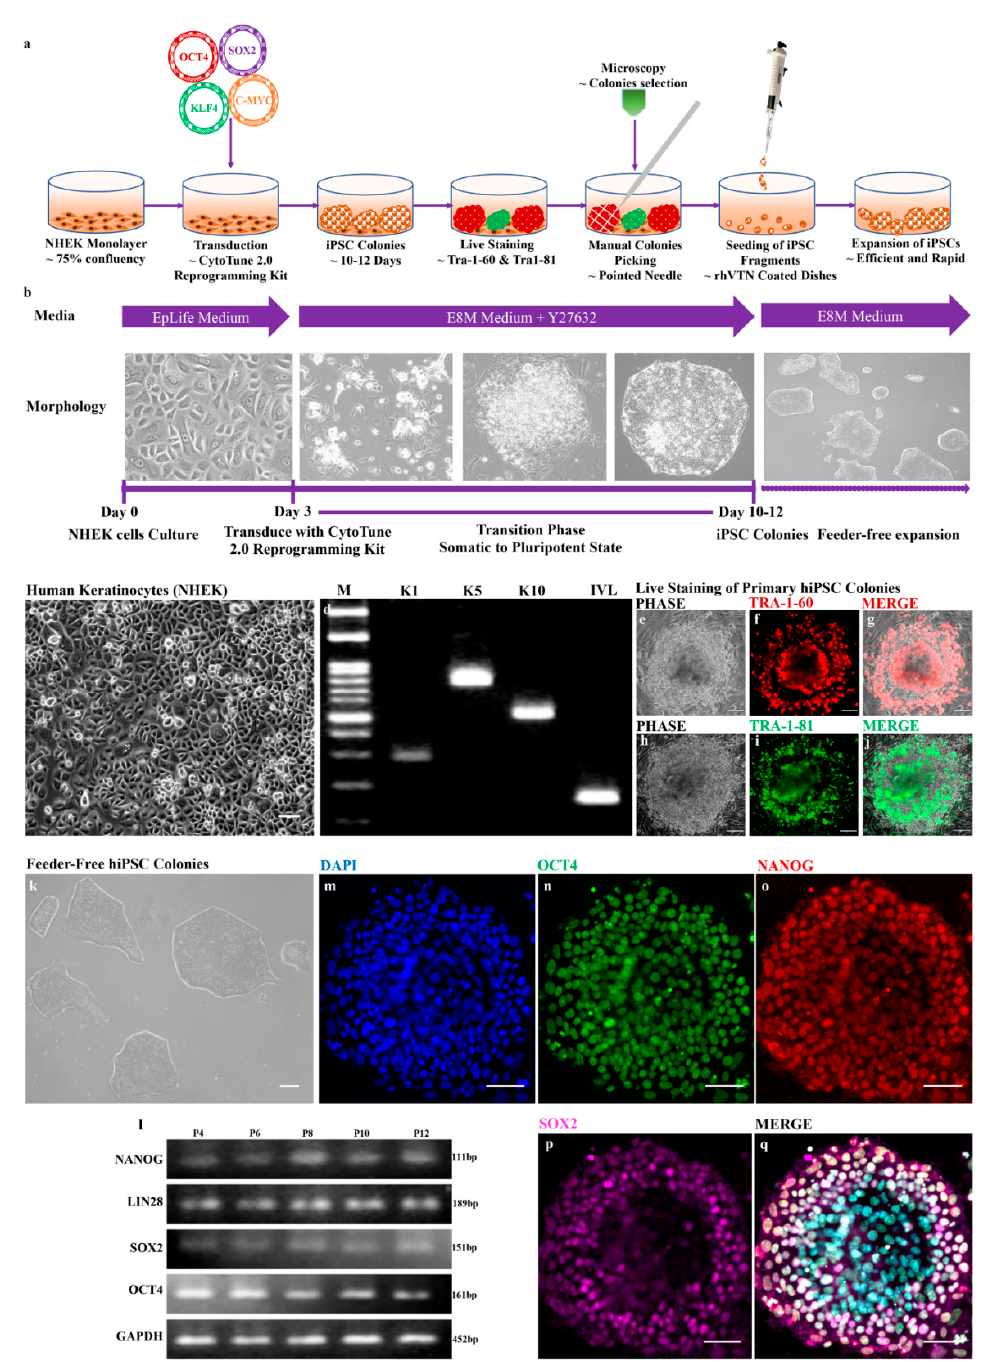
Figure 1. hiPSCs derived from normal human epidermal keratinocytes (NHEKs) exhibit pluripotency. ( a ) Schematic illustration of hiPSC generation; ( b ) Timeline showing the generation of hiPSCs from NHEK cells; ( c ) Monolayer culture of human keratinocytes (NHEK); and ( d ) reverse-transcription PCR analysis showing the expression of keratinocyte markers, such as keratin 1 ( K1 ), keratin 5 ( K5 ), keratin 10 ( K10 ) and involucrin ( IVL ); ( e – j ) live staining of primary hiPSC colonies; ( k ) Feeder-free hiPSC colonies; ( l ) reverse-transcription-PCR analysis showing the consistent expression of pluripotency markers, such as OCT4 , SOX2 , LIN28 and NANOG and the internal control ( GAPDH ) at different passages (P4, P6, P8, P10 and P12); and ( m – q ) immunocytochemistry staining of hiPSCs (P4) showing expression of pluripotency markers, such as OCT4 , SOX2 and NANOG . Scale bars, 100 μ m ( c , k ); 150 μ m ( e – j ) 590 μ m ( m – q ).